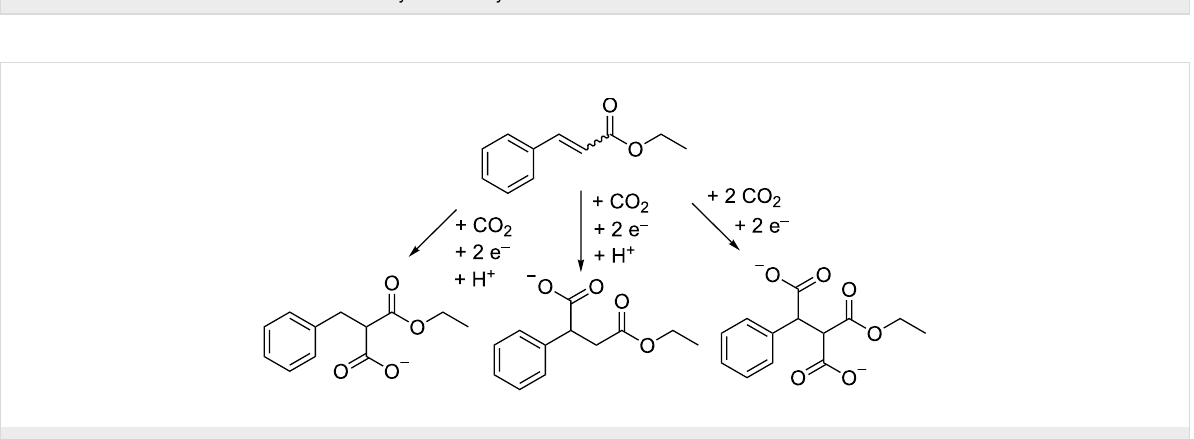
Scheme 9: General mechanism for electrocarboxylation of alkynes.